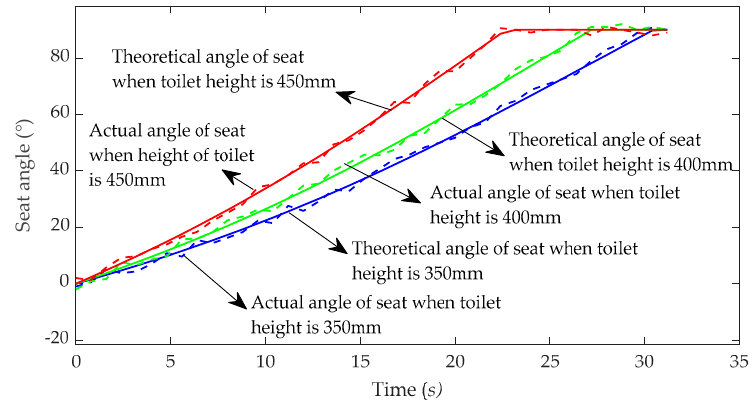
Figure 19. Experimental results of sit/stand attitude adjustment.